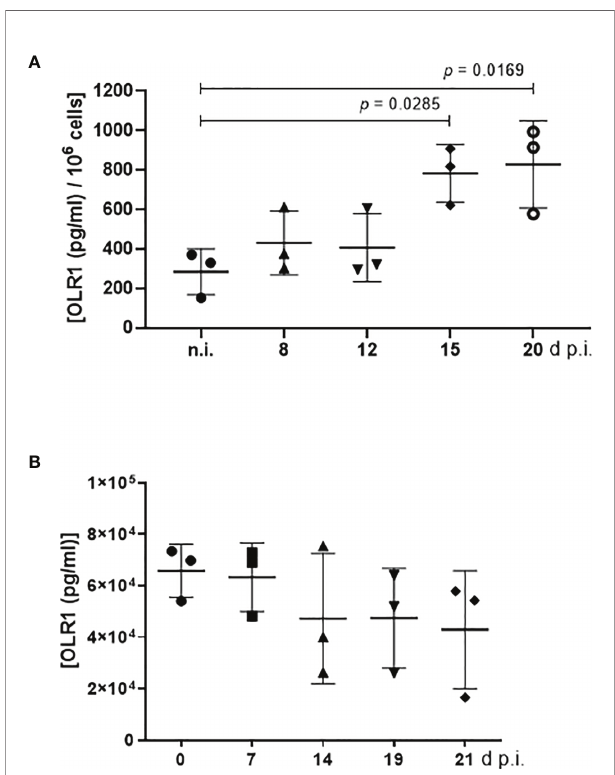
FIGURE 5 | LOX-1 (syn. OLR1) abundance in E. bovis -infected bovine umbilical vein endothelial cells (BUVEC) and in blood samples of E. bovis -infected calves. (A) LOX-1 abundance in E. bovis -infected BUVEC was monitored during fi rst merogony and revealed an increase in protein concentration [(pg/ml)/10 6 cells] over time ( n = 3, technical replicates). (B) Blood samples of three experimentally infected calves were examined for soluble LOX-1 levels throughout infection. Soluble LOX-1 was not signi fi cantly altered during infection. Mean and standard deviation; signi fi cance p <